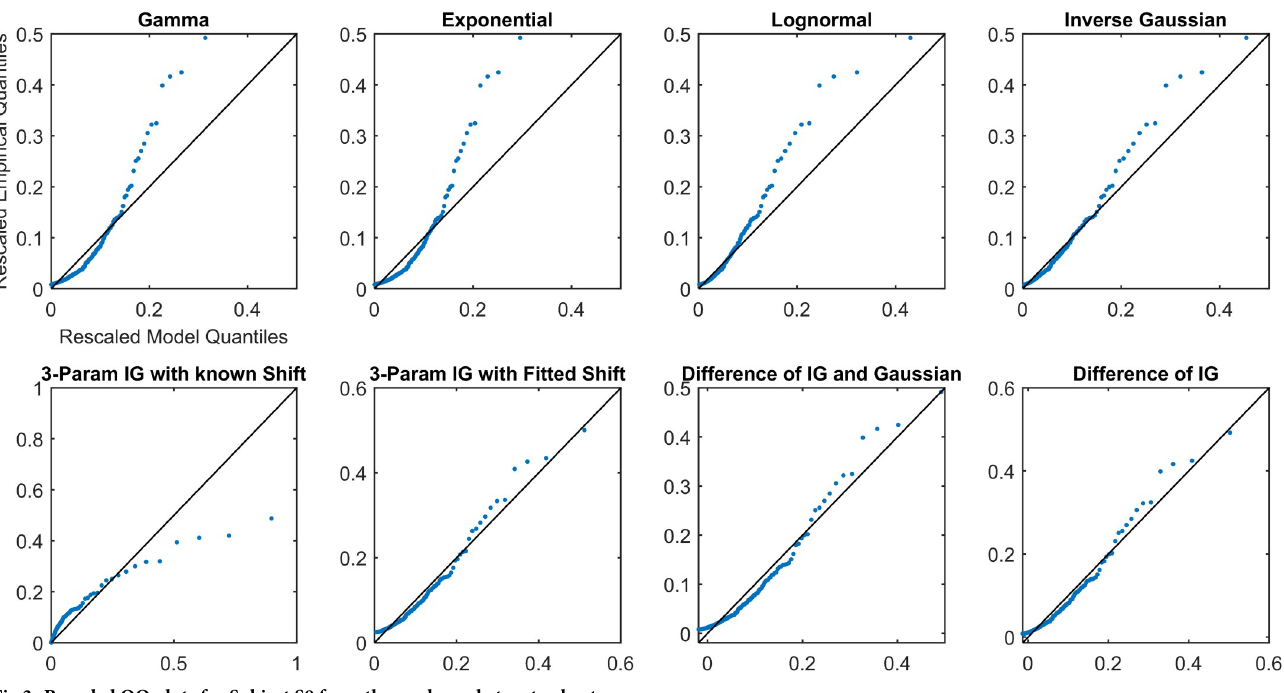
Fig 3. Rescaled QQ plots for Subject S8 from the awake and at rest cohort.